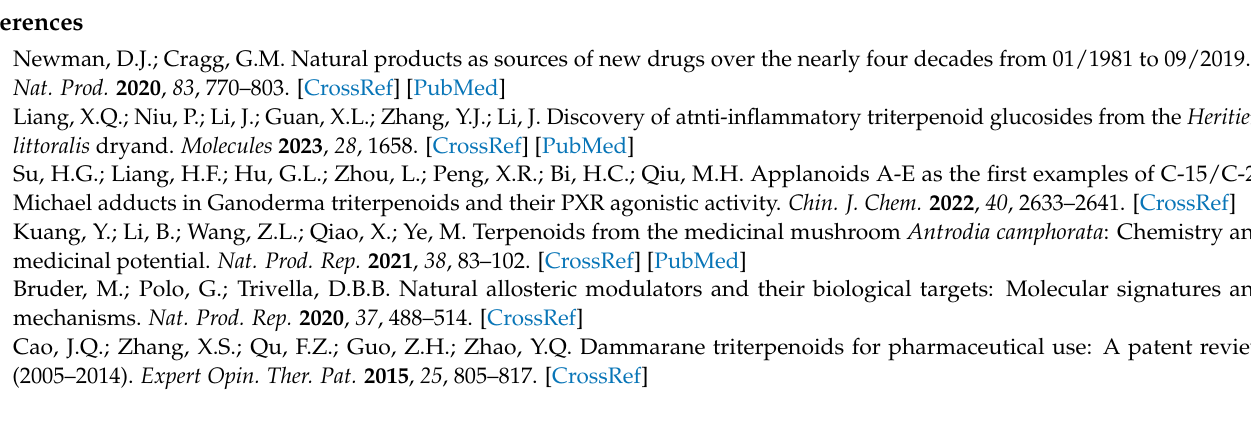
Figure S2. 1H NMR spectrum of compound 1 (600 MHz, pyridine-d5). Figure S3. 13C NMR spectrum of compound 1 (150 MHz, pyridine-d5). Figure S4. DEPT spectrum of compound 1 in pyridine-d5. Figure S5. HSQC spectrum of compound 1 in pyridine-d5. Figure S6. 1H-1H COSY spectrum of compound 1 in pyridine-d5. Figure S7. HMBC spectrum of compound 1 in pyridine-d5. Figure S8. ROESY spectrum of compound 1 in pyridine-d5. Figure S9. HRESIMS spectrum of compound 2 . Figure S10. 1H NMR spectrum of compound 2 (600 MHz, pyridine-d5). Figure S11. 13C NMR spectrum of compound 2 (150 MHz, pyridine-d5). Figure S12. DEPT spectrum of compound 2 in pyridine-d5. Figure S13. HSQC spectrum of compound 2 in pyridine-d5. Figure S14. 1H-1H COSY spectrum of compound 2 in pyridine-d5. Figure S15. HMBC spectrum of compound 2 in pyridine-d5. Figure S16. ROESY spectrum of compound 2 in pyridine-d5. Figure S17. HRESIMS spectrum of compound 3 . Figure S18. 1H NMR spectrum of compound 3 (600 MHz, pyridine-d5). Figure S19. 13C NMR spectrum of compound 3 (150MHz, pyridine-d5). Figure S20. DEPT spectrum of compound 3 in pyridine-d5. Figure S21. HSQC spectrum of compound 3 in pyridine-d5. Figure S22. 1H-1H COSY spectrum of compound 3 in pyridine-d5. Figure S23. HMBC spectrum of compound 3 in pyridine-d5. Figure S25. HRESIMS spectrum of compound 4 . Figure S26. 1H NMR spectrum of compound 4 (600 MHz, pyridine-d5). Figure S27. 13C NMR spectrum of compound 4 (150MHz, pyridine-d5). Figure S28. DEPT spectrum of compound 4 in pyridine-d5. Figure S29. HSQC spectrum of compound 4 in pyridine-d5. Figure S30. 1H-1H COSY spectrum of compound 4 in pyridine-d5. Figure S31. HMBC spectrum of compound 4 in pyridine-d5. Figure S32. ROESY spectrum of compound 4 in pyridine-d5. Figure S33. The HPLC spectrum of the standard of L-arabinose. Figure S34. The HPLC spectrum of the standard of D-glucopyranose. Figure S35. The HPLC spectrum of the standard of D-quinovose. Figure S36. The HPLC spectrum of the compound 1 of L-arabinose. Figure S37. The HPLC spectrum of the compound 2 and 3 of D-glucopyranose and L-arabinose. Figure S38. The HPLC spectrum of the compound 4 of L-arabinose and